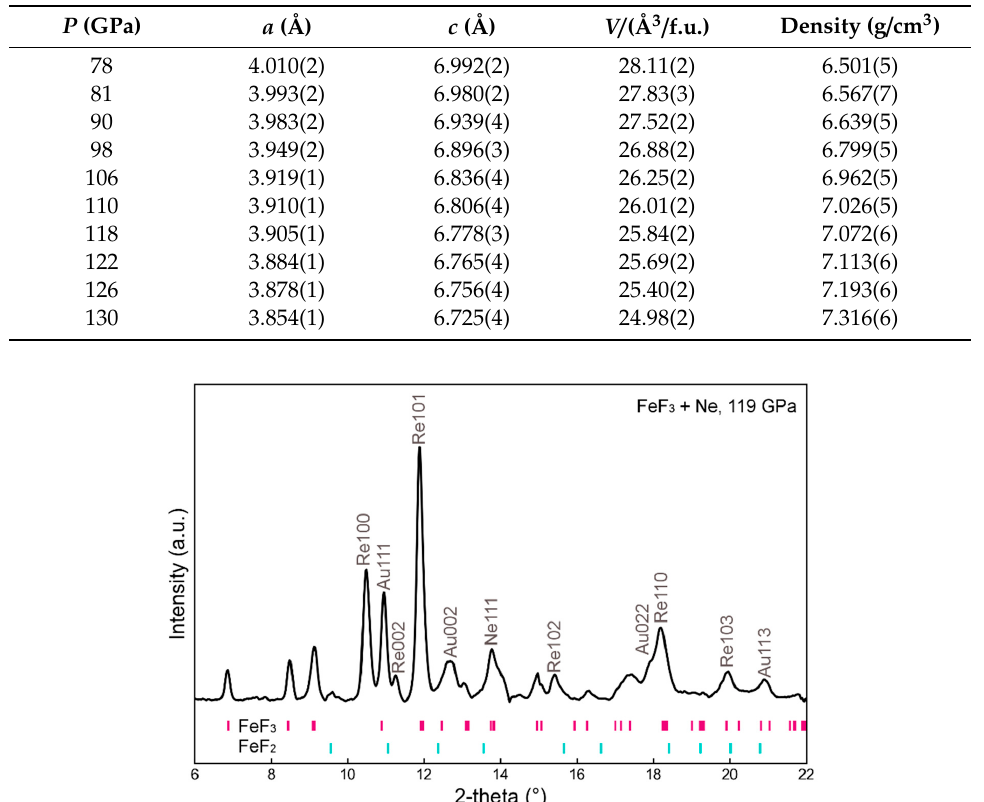
Table 1. Lattice parameters of tetragonal FeF 3 up to 130 GPa and 1900 K.